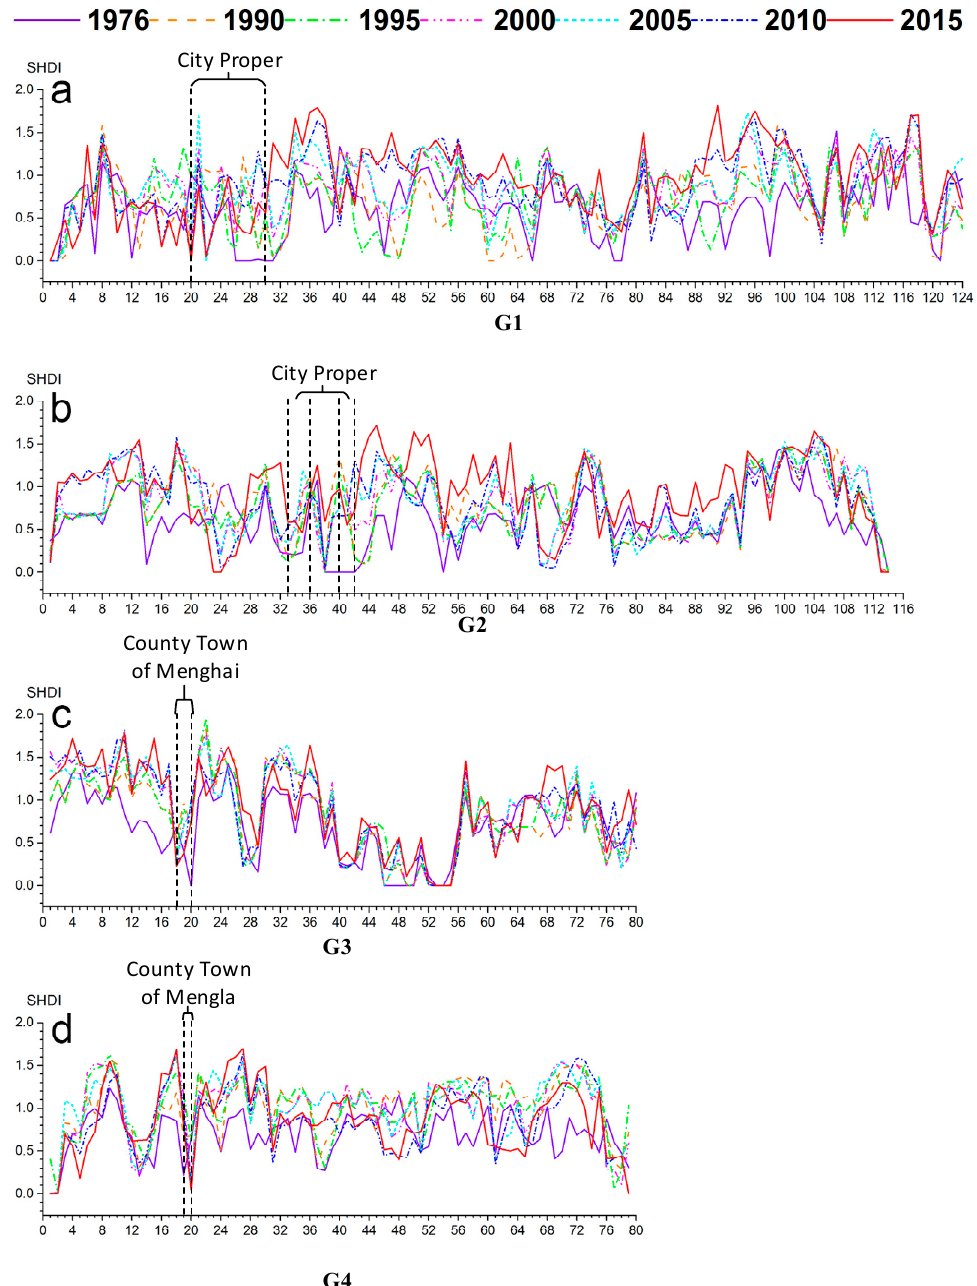
Figure 7. Shannon’s Diversity Index (SHDI) along four urban-rural gradients. X-axes represent the number of sampling blocks from the starting directions.